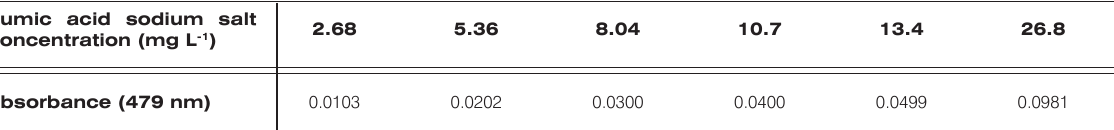
Table 1. Absorbance of humic acid solutions.